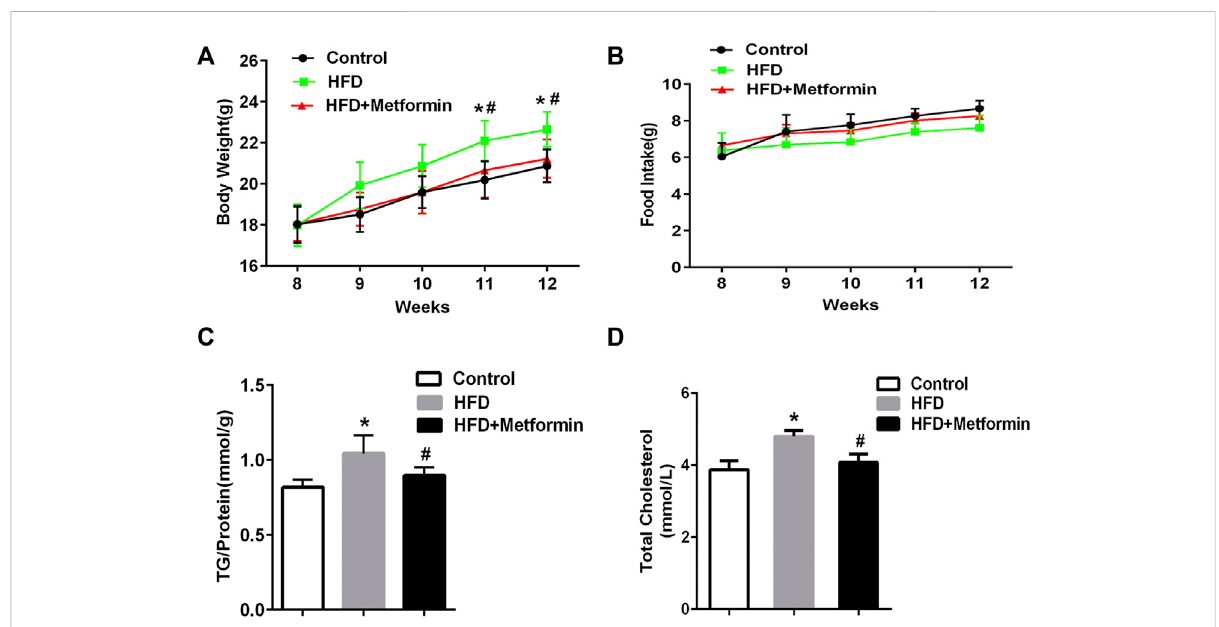
FIGURE 1 Metformin treatment reduced hepatic TG content in mice. (A) Body weight, (B) total food intake, (C) cellular TG content in the liver, and (D) total serum cholesterol inmice fedcontrol diet or HFD withor without metformin treatment for 5 weeks. Data are presented as the mean± SEM. p p < 0.05 compared with control mice. #p < 0.05 compared with HFD-fed mice, n = 6 –